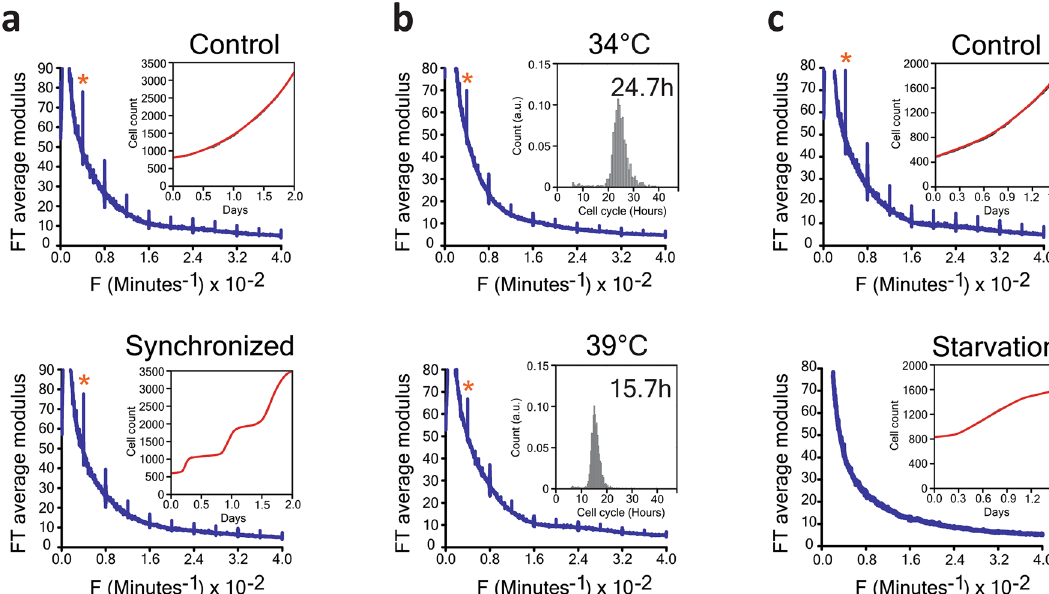
Figure 2. Effect of the cell cycle manipulation on the rhythm. ( a ) Synchronization of HeLa cells using a double thymidine block does not affect the rhythm. The inserts show cell growth curves for the control and synchronized cells plotted using the data from direct cell counts by lens-free microscopy. ( b ) Comparison of HeLa cells at 34 °C (top) and 39 °C (bottom). The characteristic frequency of the rhythm does not change despite the significant change in the cell cycle length (inserts). ( c ) Serum starvation eliminates the 4 h rhythm. The inserts show cell counts in control (top) and serum starvation (bottom) Fig. S3). Cell dry mass dynamics were analyzed during the interphase, from the first detected mitotic event until the following, or until the track was lost. For each cell, we computed the Fourier transform (FT) of the dry mass change during the interphase trajectory. The averaged absolute amplitude was normalized by trace length. The dry mass history in mouse embryonic fibroblasts (MEFs) revealed a dominant frequency of 0.004 min −1 , and higher harmonics, superimposed on 1/f noise (Figs. 1b,c). Reconstruction of the signal by applying an inverse Fourier transform to exclude the noise, reveals periodic symmetric spikes, 30 min wide, every 4.17 h (SD = 0.0039 h) (Fig. 1d and Supplementary Fig. S5). In Hela, U2OS, MEF, CHO-K1, NHEK and NHDF cells we also observed the same principal frequency of 0.004 min −1 (Fig. 1e). The amplitude of the dry mass change was